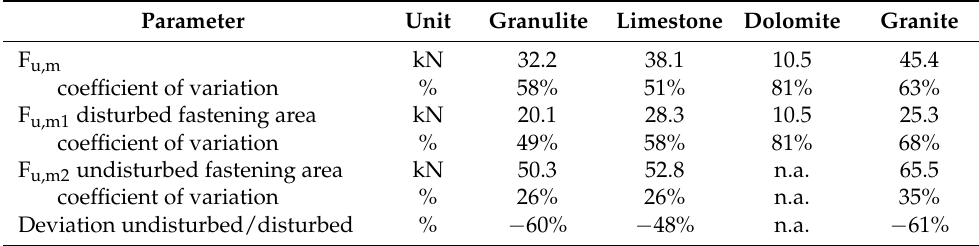
Table 3. Comparison of failure loads for the different rock types for disturbed and undisturbed areas.